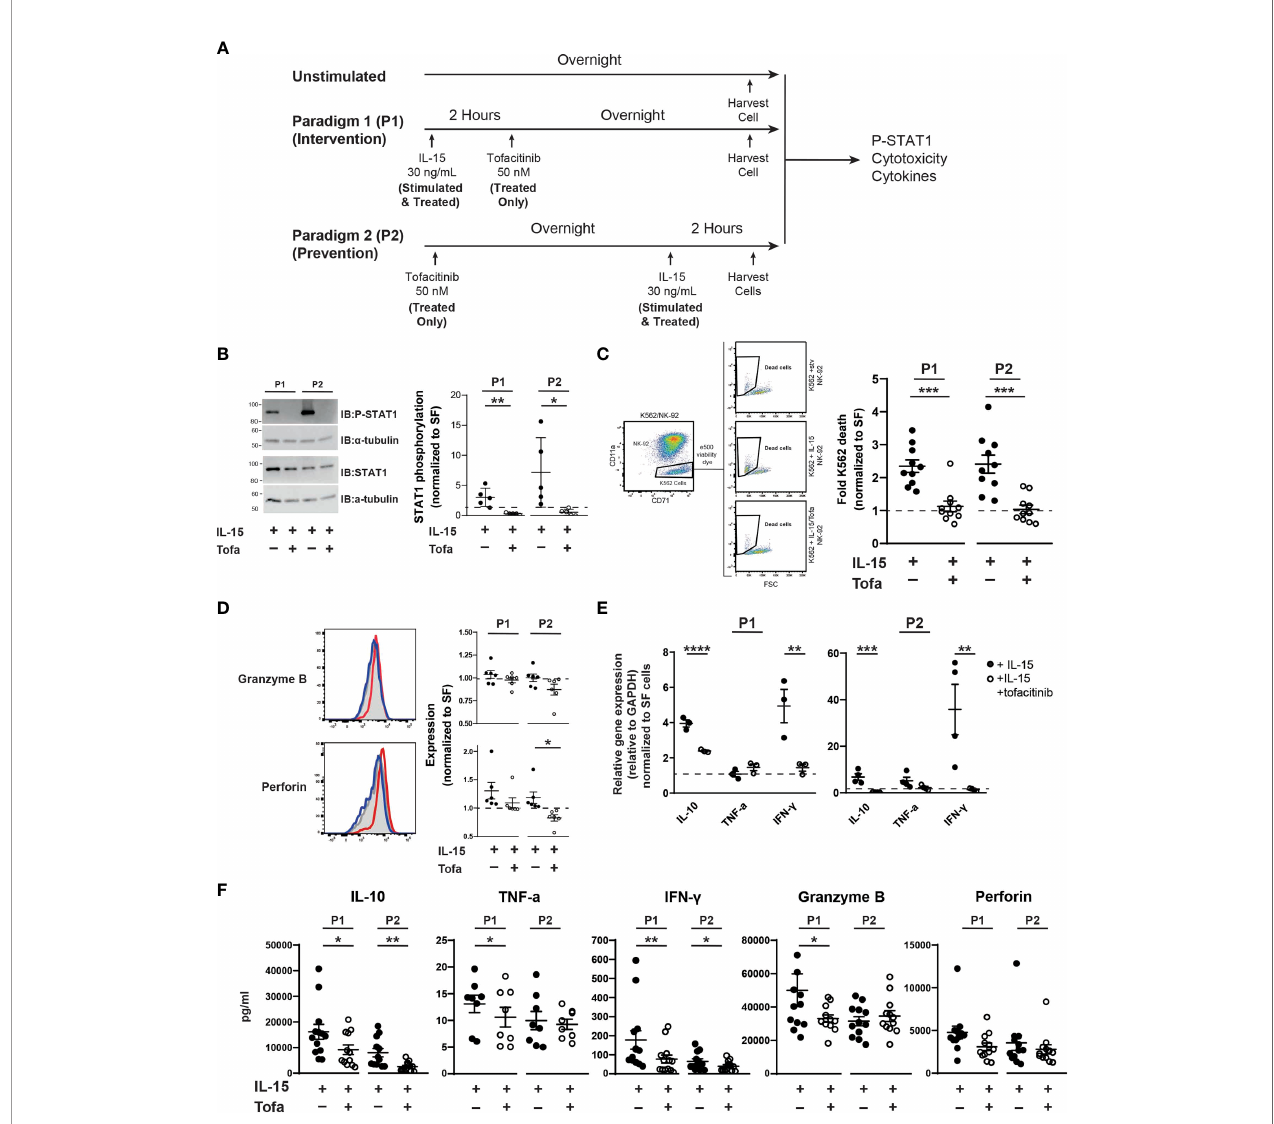
FIGURE 1 | Tofacitinib inhibits NK-92 cells function in vitro . (A) NK-92 cells were cultured with serum-free media under two culture paradigms: Paradigm 1 (P1) intervention treatment, whereby NK-92 cells were treated with IL-15 for two hours and then cultured overnight in the presence of tofacitinib (Treated), and Paradigm 2 (P2) prevention treatment where NK-92 cells were treated overnight with tofacitinib prior to two-hour IL-15 stimulation. (B) Stimulated and Treated NK-92 cells were assessed for STAT1 phosphorylation (P-STAT) following both culture paradigms. Representative immunoblots for Stimulated and Treated P-STAT1 and a - tubulin (internal reference) are shown. Quantitative data represent densitometric analysis, where total STAT1 and P-STAT1 signals were fi rst normalized to a -tubulin then to P-STAT1 levels in Unstimulated cells; n = 5 independent experiments. (C) Unstimulated, Stimulated, and Treated NK-92 cells were co-cultured with K-562 cancer cells (10:1 ratio) following initial P1 or P2 culture paradigms. Flow cytometry was used to identify K-562 cells in the co-culture, and cell death was assessed by viability dye staining. K-562 cell death was quantitated for Stimulated and Treated NK-92 cells and normalized to Unstimulated NK-92 cells; n = 10 independent experiments. (D) Expression of the intracellular NK cell proteins perforin and granzyme B was determined by fl ow cytometry on Unstimulated, Stimulated, and Treated NK-92 cells using intracellular fl ow cytometry following P1 and P2 culture paradigms. Representative histograms are shown; gray peaks = Unstimulated NK- 92 cells, red peaks = Stimulated NK-92 cells, blue peaks = Treated NK-92 cells show MFI. MFI from Stimulated and Treated cells were normalized to protein levels in Unstimulated NK-92 cells for quantitation; n = 6 independent experiments. (E) Gene expression of IL-10, TNF- a , and IFN g cytokines was assessed in Unstimulated, Stimulated, and Treated NK-92 cells following P1 and P2 paradigms using qRT-PCR. Data for Stimulated and Treated cells were normalized to GAPDH expression then to the Unstimulated cells; n = 3-4 independent experiments. (F) Extracellular expression of IL-10, TNF- a , IFN- g , granzyme B, and perforin was assessed for Stimulated and Treated NK-92 cells using a CD8/NK cell multiplex analysis following P1 and P2 treatment paradigms (n = 8-13 independent experiments). For all experiments, quantitative data is shown as the mean ± SEM; (A – E) comparisons were made by Student ’ s t-test; (F) comparisons were made using a paired t-test or a Wilcoxon test based on normality of the data. Horizontal dashed lines represent normalized Unstimulated NK-92 cell levels. * P <0.05, ** P <0.01, *** P <0.001, **** P